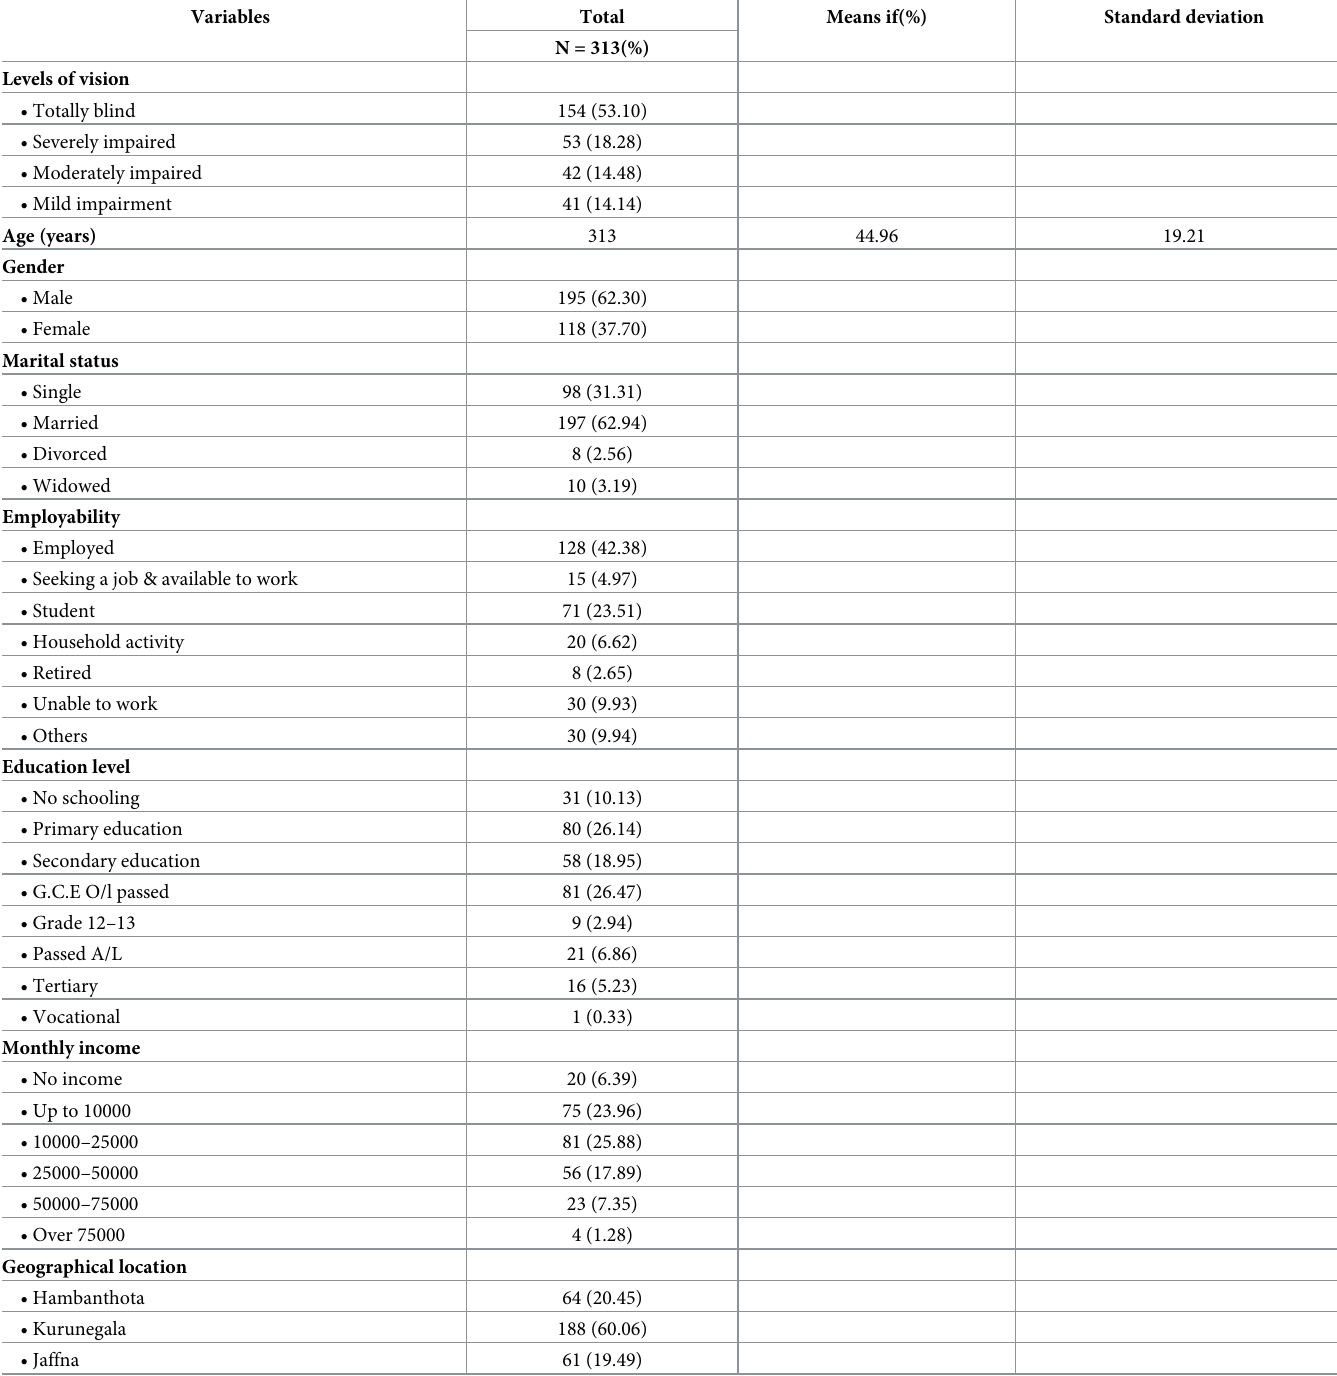
Table 3. Distribution of socio-economic characteristics among all participants with visual impairment and